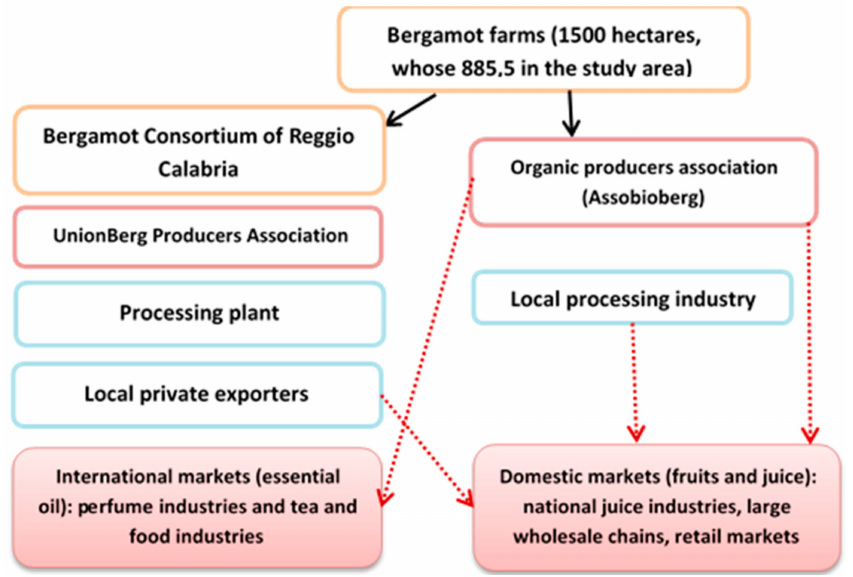
Figure 3. The bergamot value chain in Grecanic